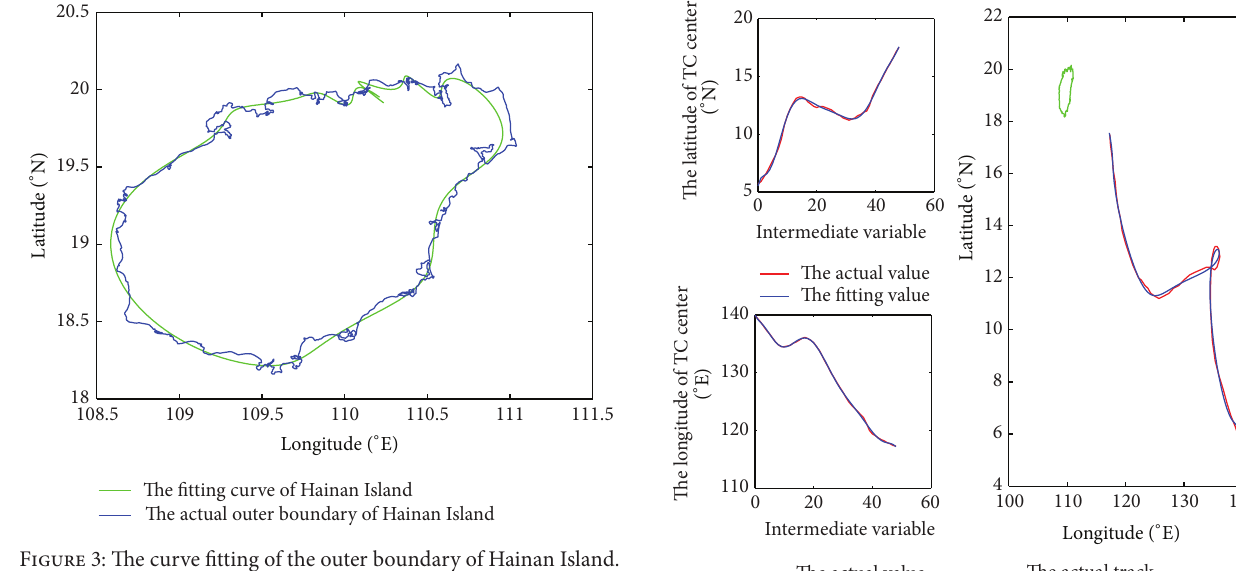
Figure 3: The curve fitting of the outer boundary of Hainan Island.